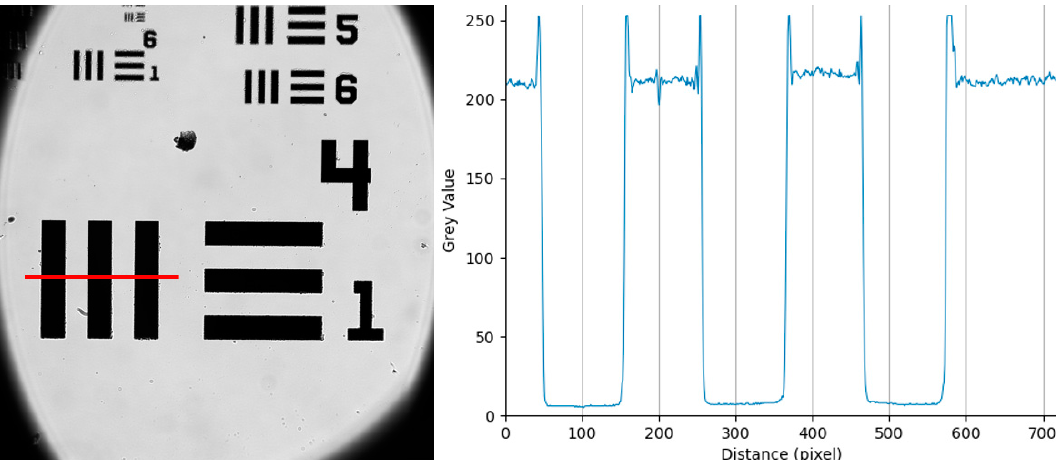
Figure 2. The captured image of a 1951 USAF target, measuring along group 4:1 to minimize measurement error, the average line width was 99 pixels. Group 4:1 has a line width of 31.25 µm. Red line represents line profile taken for line plot.